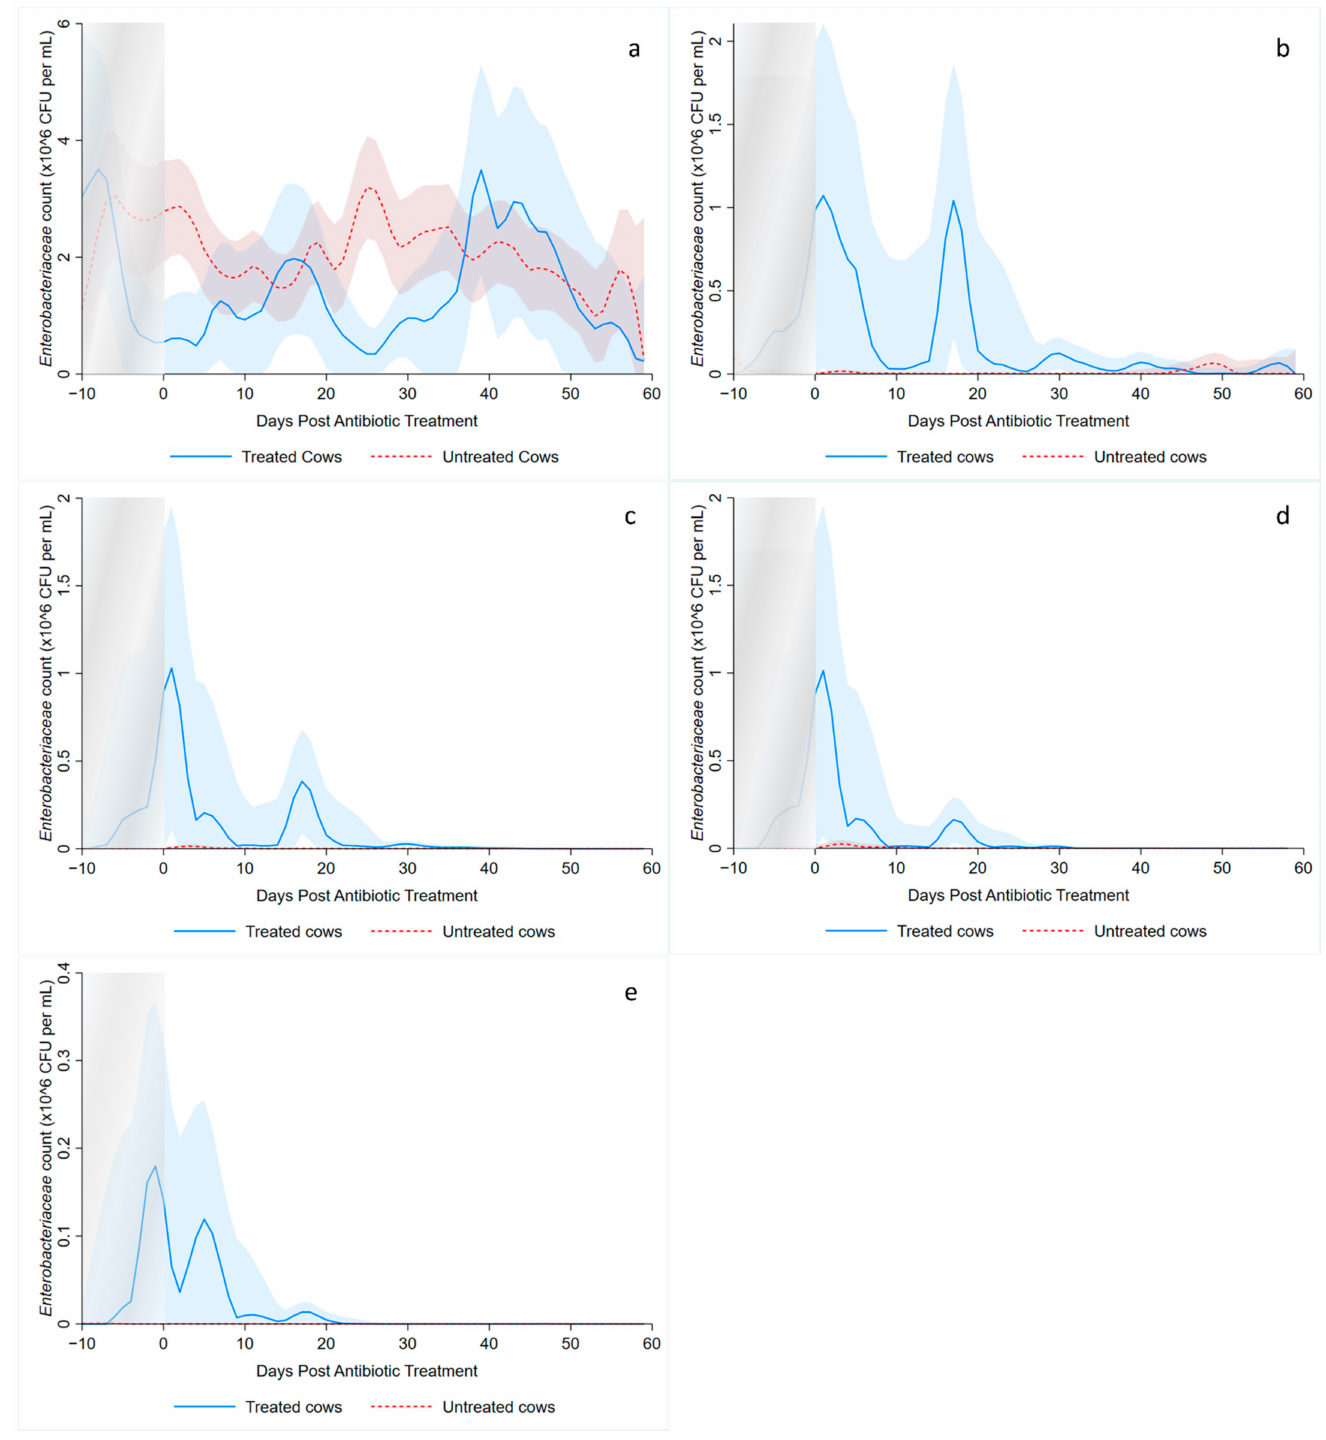
Figure 2. Kernel-weighted local polynomial smoothed regression plots for Enterobacteriaceae counts in cows treated with systemic antimicrobial drugs and time-matched untreated cows by days post-antibiotic treatment. Counts for ceftiofur resistance at ( a ) 0–1 µ g/mL ( b ) ≥ 1 µ g/mL ( c ) ≥ 8 g/mL ( d ) ≥ 16 µ g/mL ( e ) ≥ 30 µ g/mL. Shaded areas around the regression lines are the 95% confidence intervals. For treated cows, data between − 10 to 0 days post-antibiotic treatment combine cows currently receiving treatment and pre-treatment cows, due to varying treatment duration (indicated by the shaded